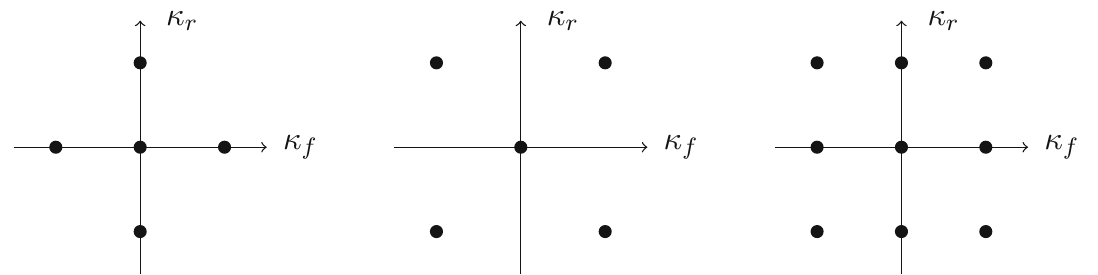
scales κ f = κ r = 0. We show the three prescriptions 5-point (left), ¯ 5-point (center) and 9-point